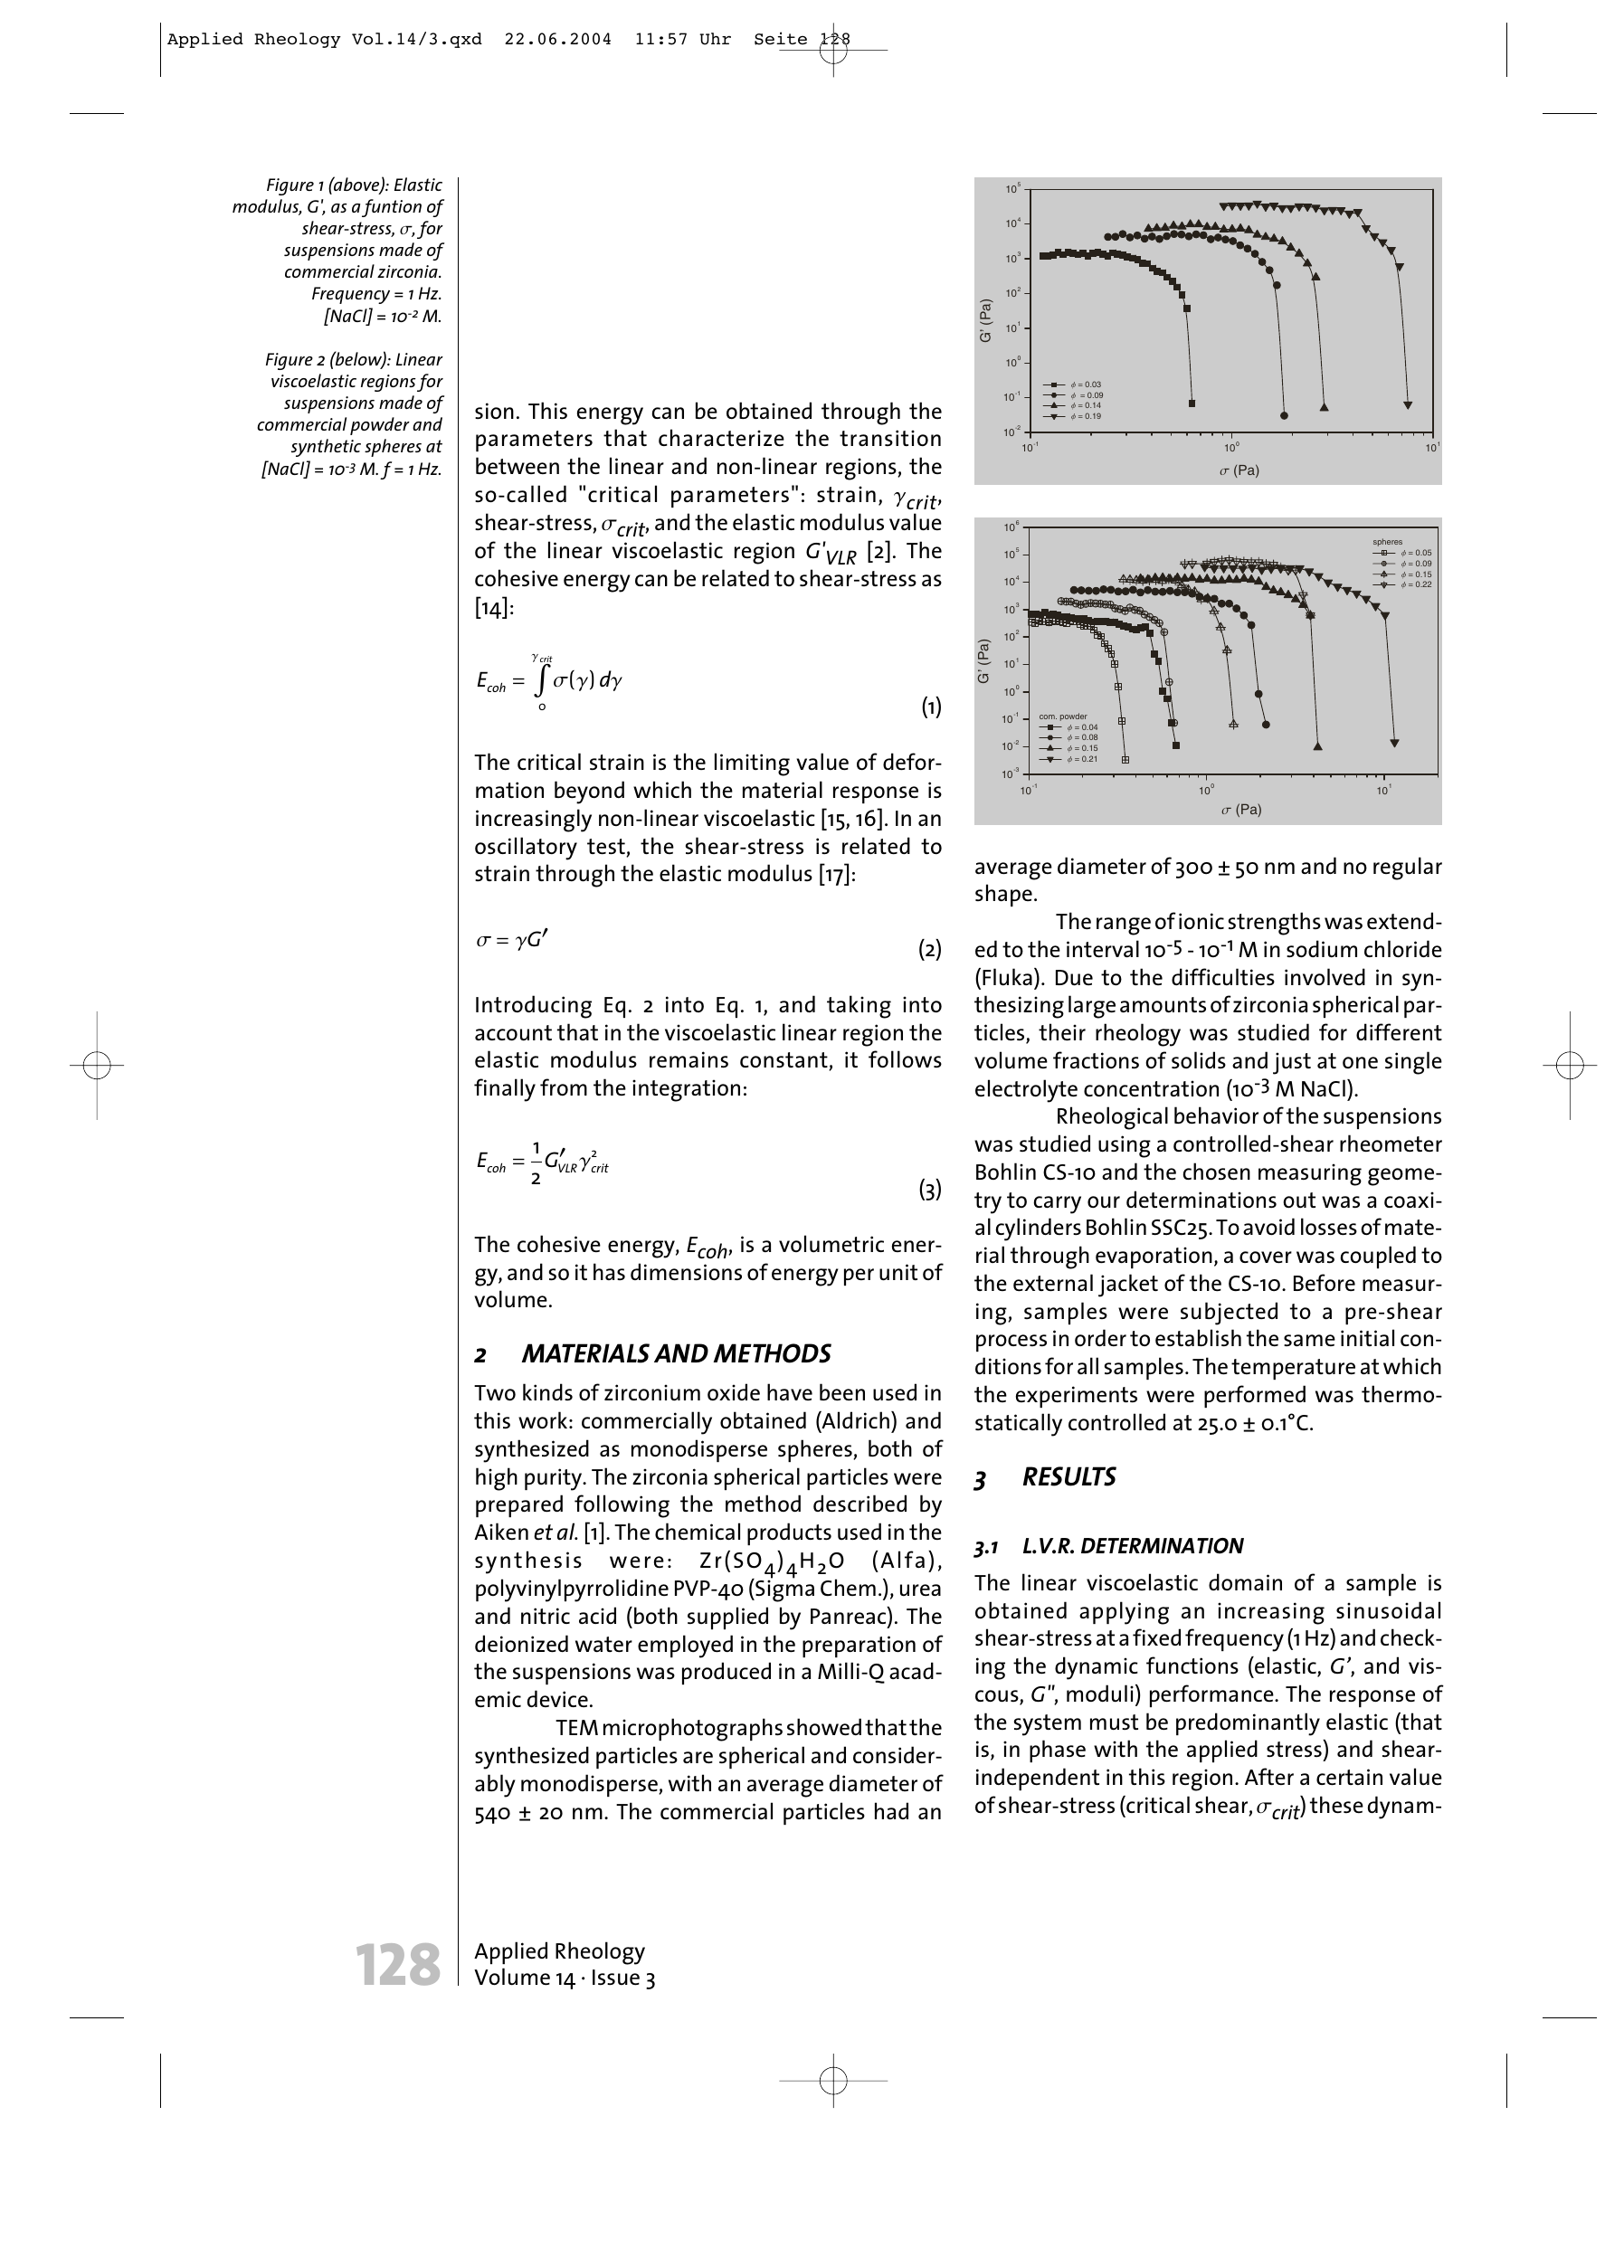
Figure 1 (above): Elastic modulus, G', as a funtion of shear-stress, s , for suspensions made of commercial zirconia. Frequency = 1 Hz.